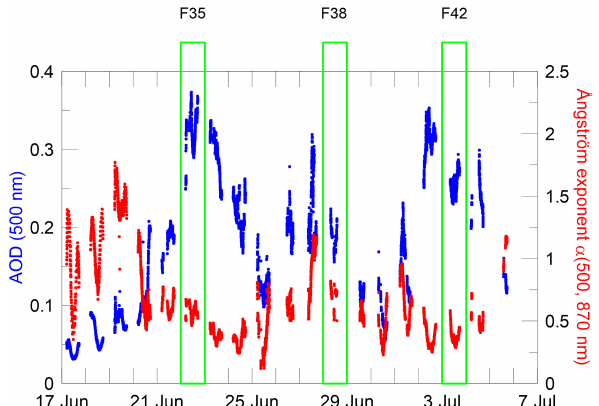
Figure 1. AOD at 500nm (blue dots) and Ångström exponent (red dots) measured by the MFRSR during the